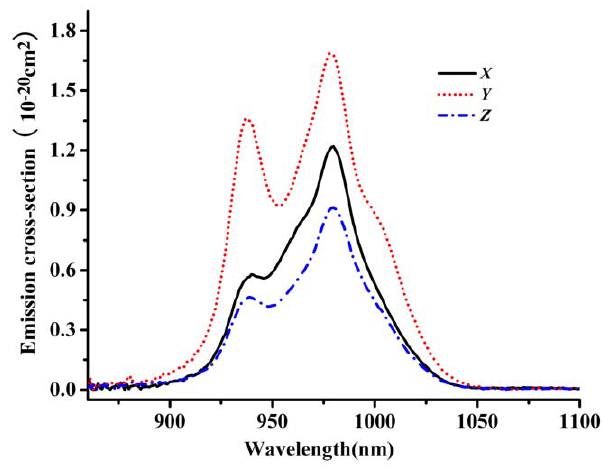
Figure 4. Polarized absorption of Yb 3 + :KBaGd(MoO 4 ) 3 crystal at room temperature.